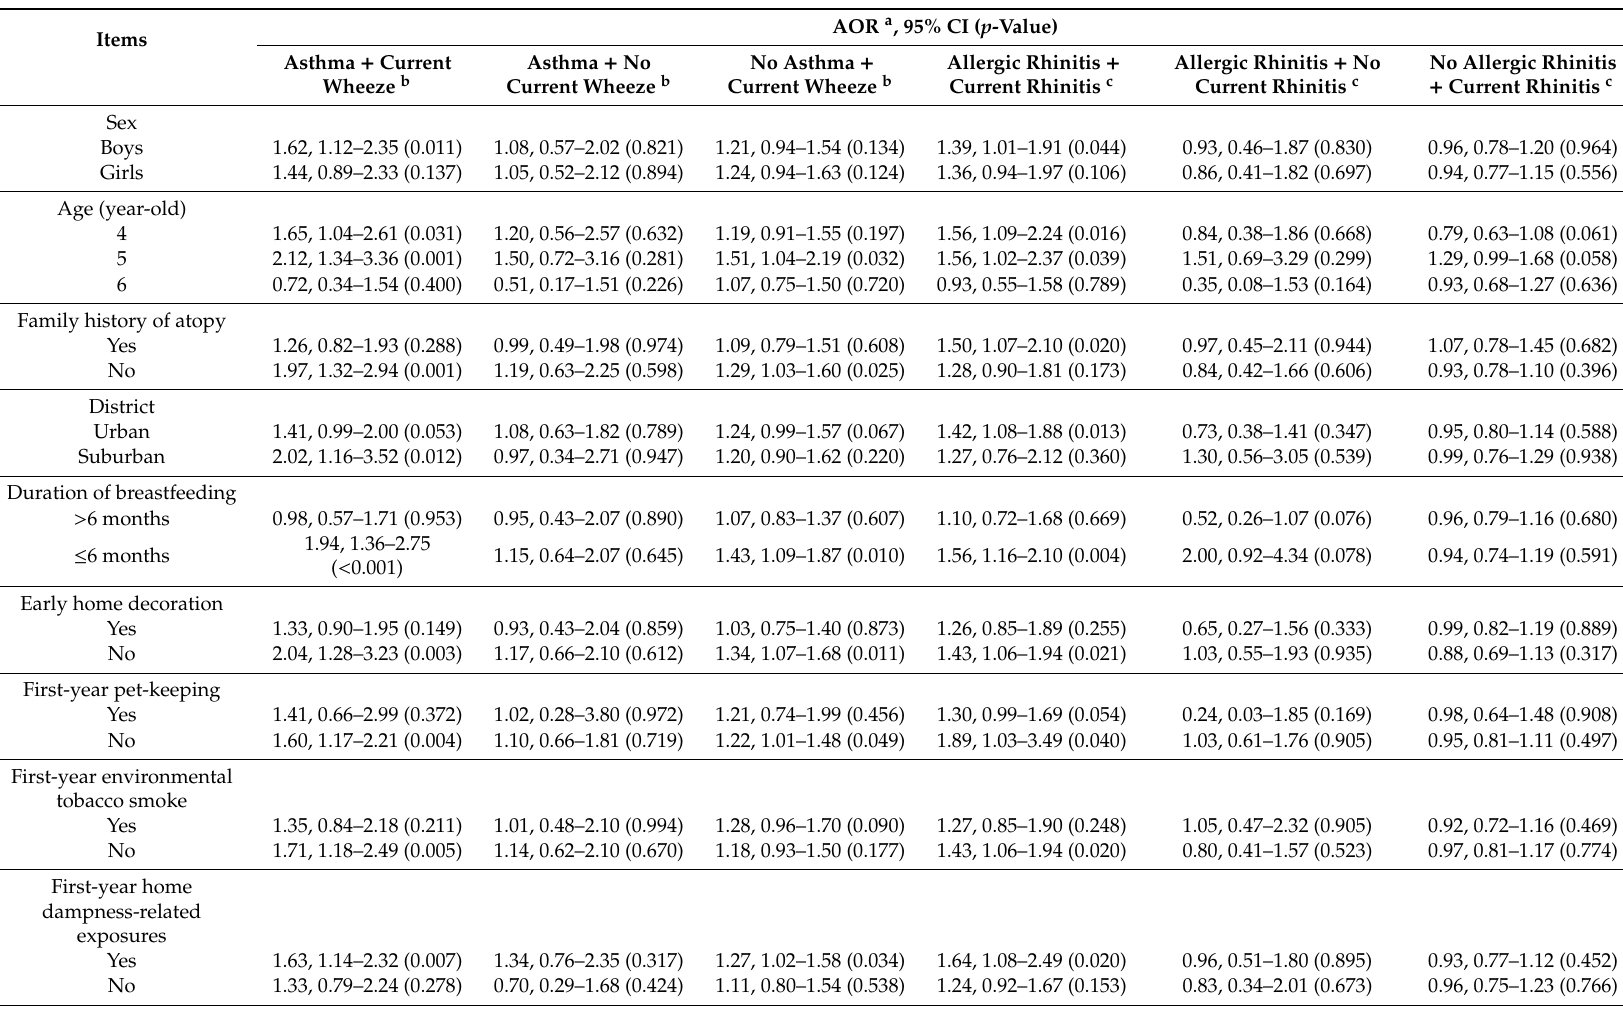
Table 9. Associations of first-year antibiotics exposure with the combinations of lifetime-ever and current illnesses in